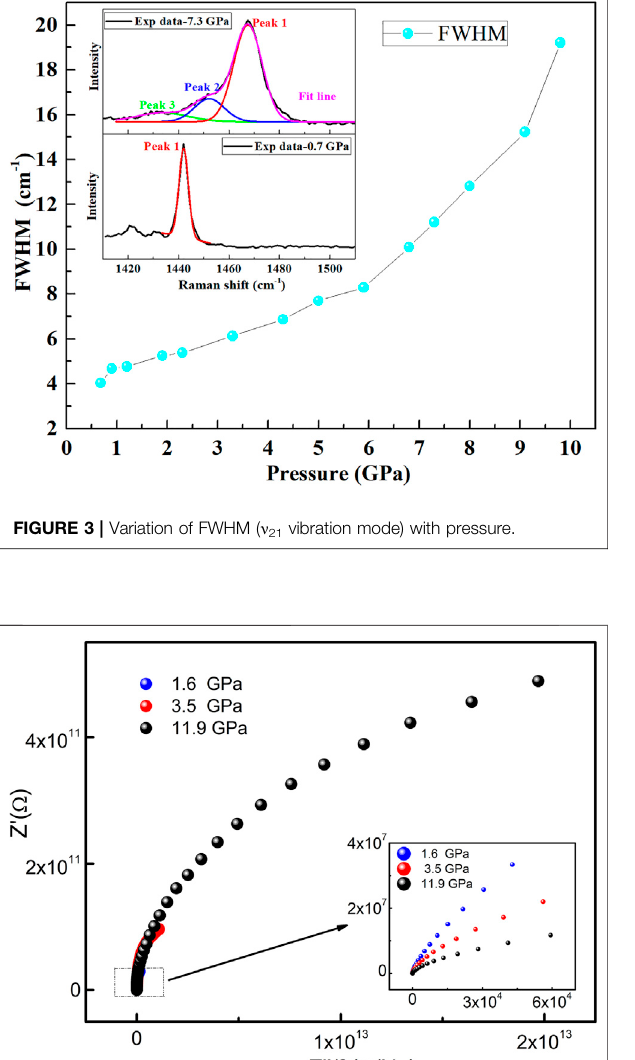
Frontiers in Physics |